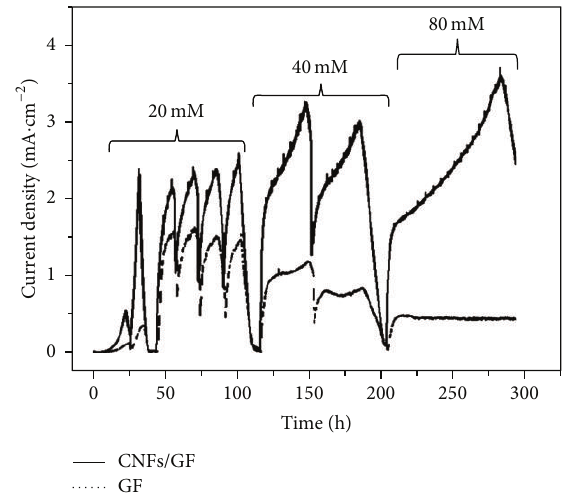
Figure 2: Biocatalytic current generation curves of GF (curves of dotted line) and CNFs/GF (curves of solid line) under different concentration of acetate measured in a half cell at 35 ∘ C. The arrows indicate the replenishment of the substrate with different concentration of